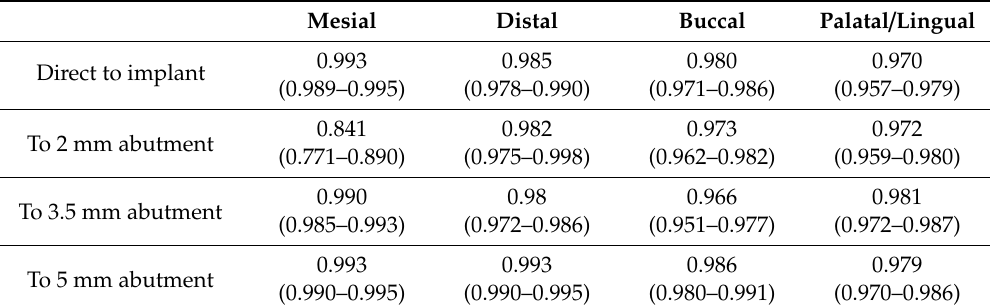
Table 2. Intraclass Correlation Coe ffi cients (ICC) according to Osstell´s probe orientation obtained during the first and the second measurement for each experimental group p < 0.001 (CI 95%). Mesial Distal